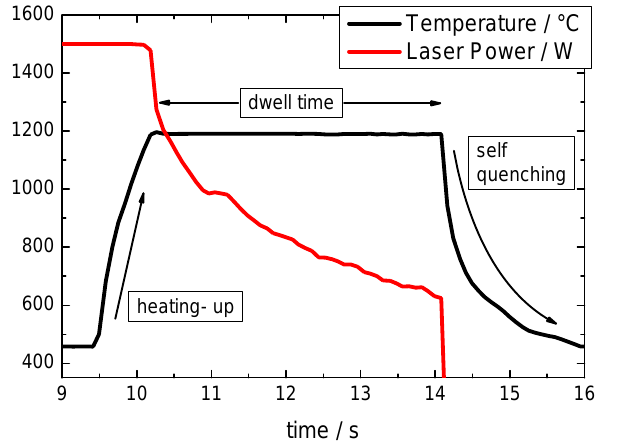
Figure 3. Process data of a temperature-controlled laser heat treat- ment process for the end face of a screw; temperature measured with pyrometer MAURER KTR 1075.